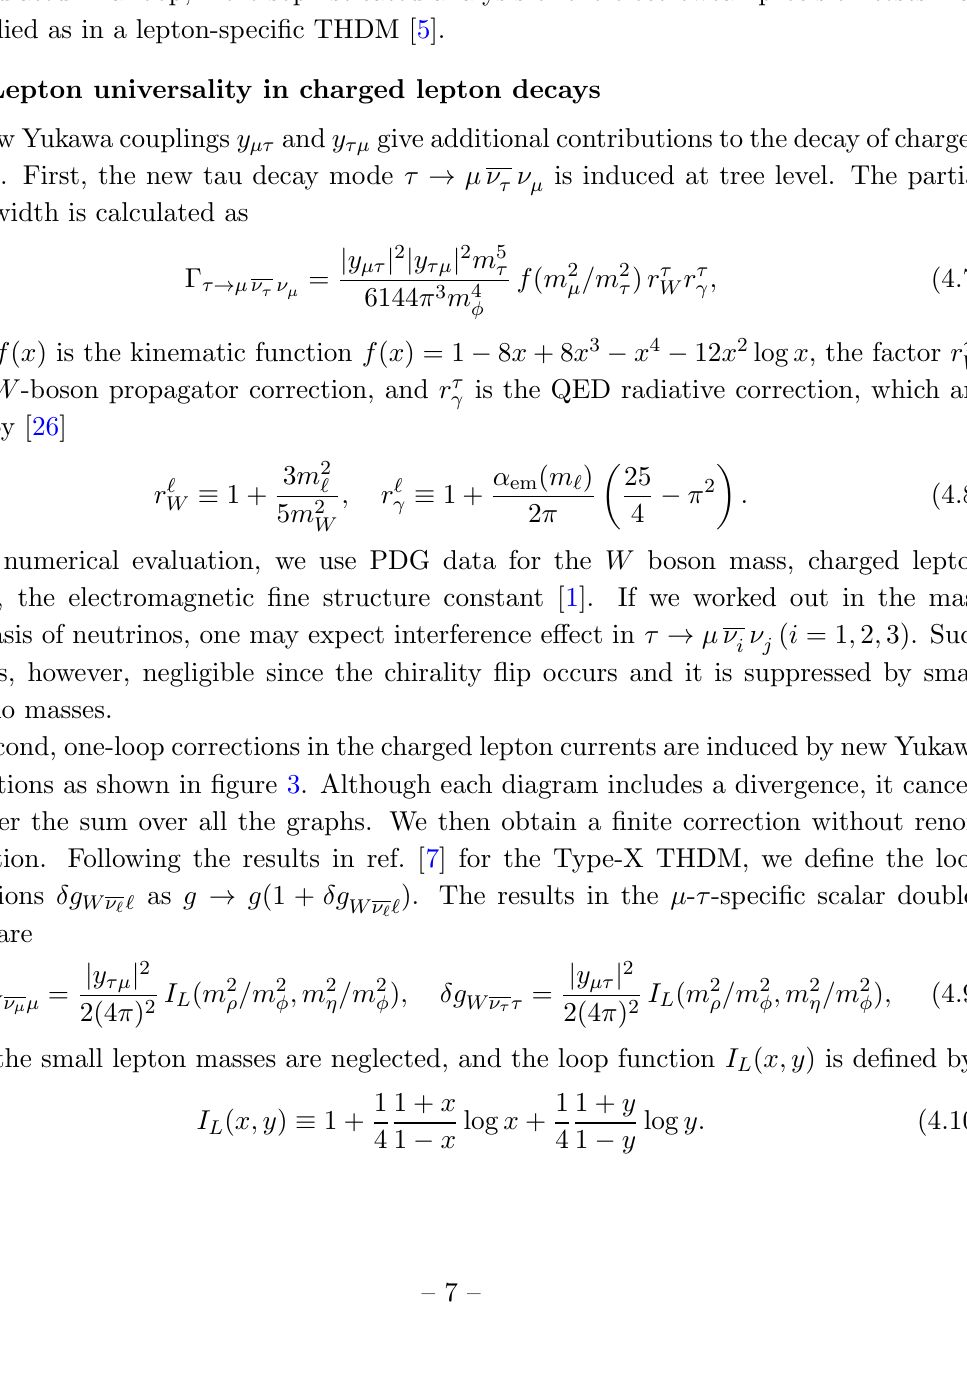
gW + (cid:23) ‘ (cid:13) (cid:22) ‘ L (cid:22) L (cid:0)